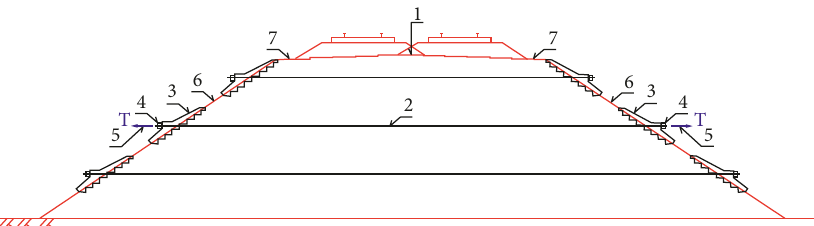
Figure 2: Schematic diagram of a prestressed embankment (1 head; 5 prestressing force; 6 (cid:31)